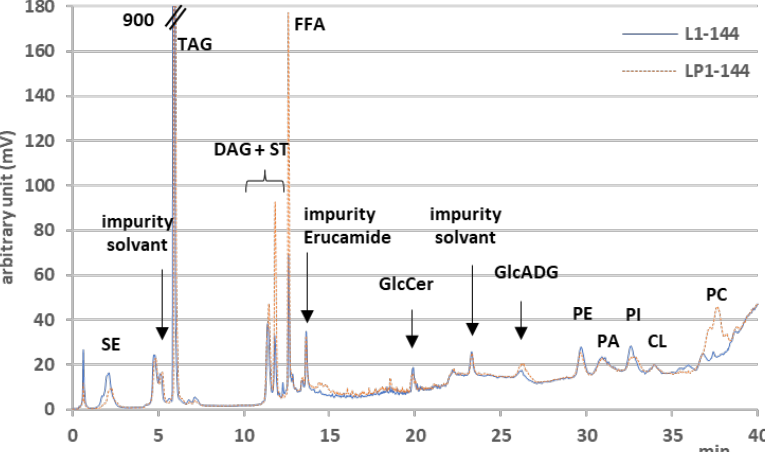
Figure 3. LC-Corona-CAD ® lipid profiles from obese L1-144 and obese LP1-144. SE—sterol esters; TAG—triacylglycerols; DAG—diacylglycerols; ST—sterols, FFA—free fatty acids; GlcCer—glucosylceramides; GlcADG—glycosyldiacylglycerols; PE—phosphatidylethanolamines; PA—phosphatidic acids; PI—phosphatidylinositols; CL—cardiolipins; PC—phosphatidylcholines. Figure 4 represents the peak areas of the storage lipid classes as obtained in LC-Co- rona-CAD ® . 90 80 Figure 4. Comparison of the storage lipid content in the obese L and obese LP over time. SE—sterol esters; TAG—triacylglycerols; DAG—diacylglycerols; FFA—free fatty acids. Mean values are dis- played ( n = 3, ± SD). TAG amounts are comparable between the two strains and do not vary significantly over time, as described in Figure 4. Similarly, the amounts of SEs, DAGs, and FFAs were similarly maintained over the cultivation time in the obese L strain. On the contrary, the 0102030 4050 60 70